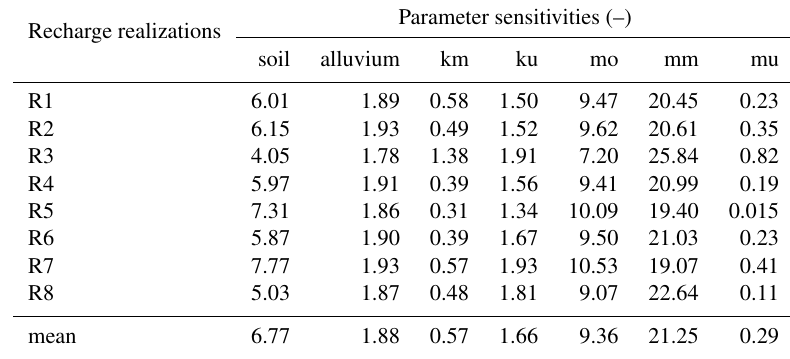
Table B1. Composite parameter sensitivities to the groundwater head